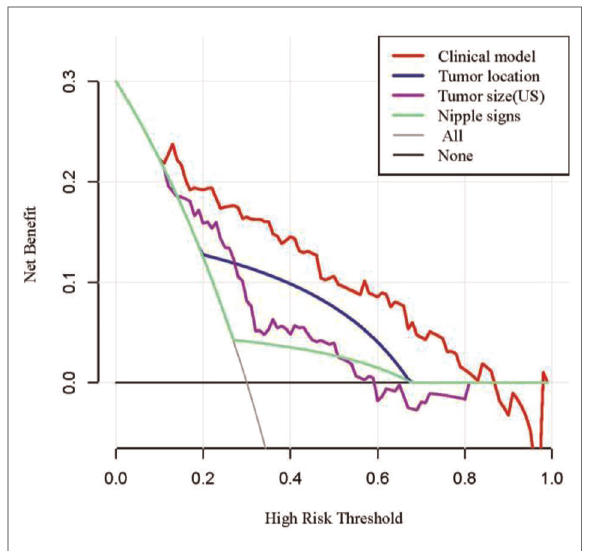
FIGURE 3 DCA of the clinical model in predicting NI. DCA, decision curve analysis; US,